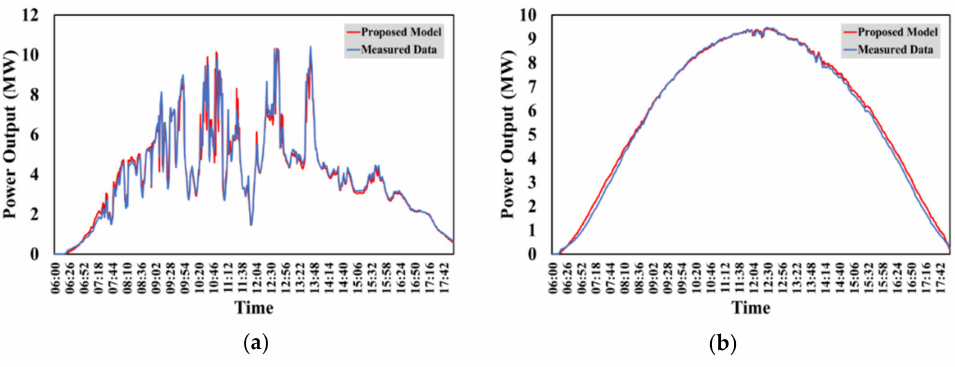
Figure 13. The proposed model and the measured data of the PV power output on a cloudy day ( a ) and a sunny day ( b